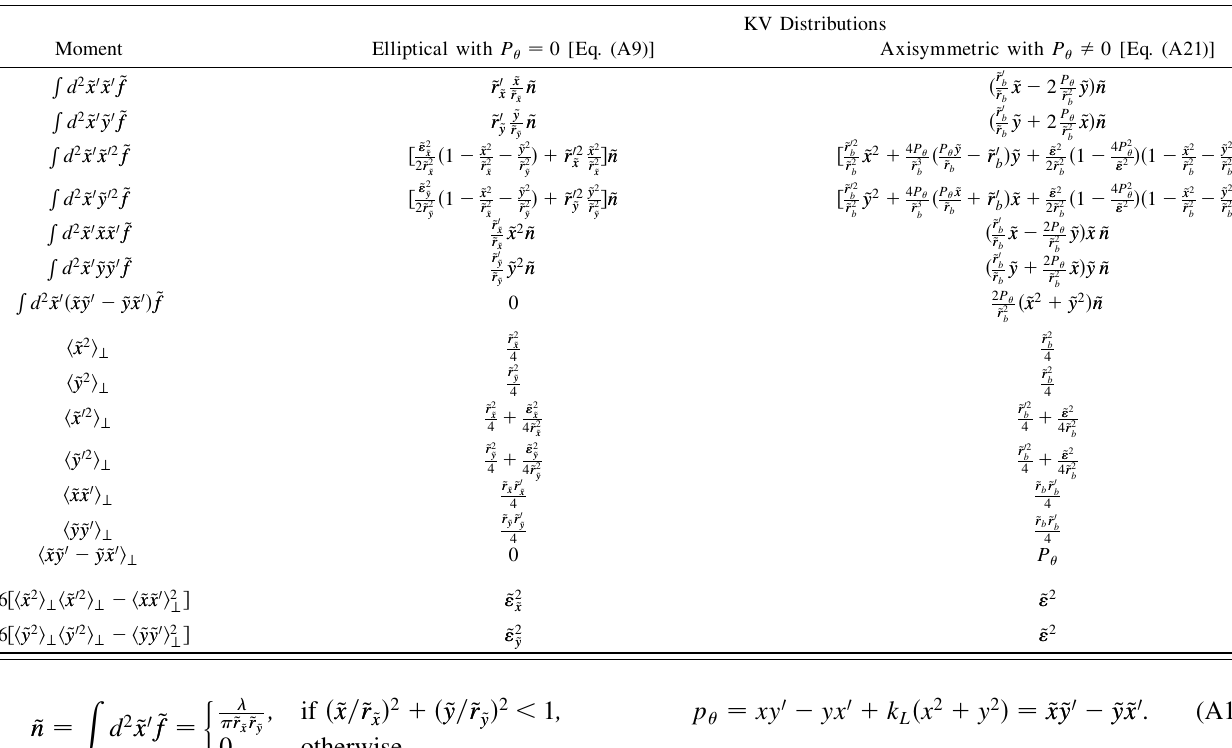
(cid:1) 0 [Eq. (A9)] and an axisymmetric beam with 4 KV Distributions